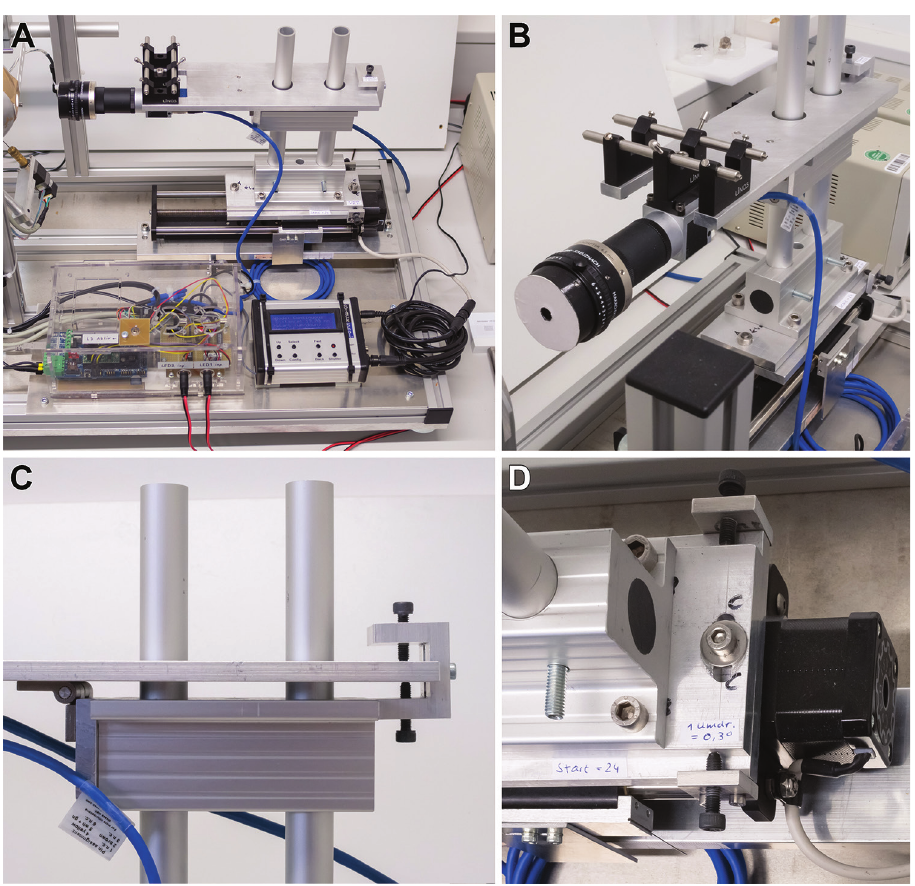
Figure 3. The camera is mounted on a macro-rail ( A ). The camera position and orientation can be fine- tuned in all directions ( B–D ). The camera lens is covered by a pinhole-cap ( B